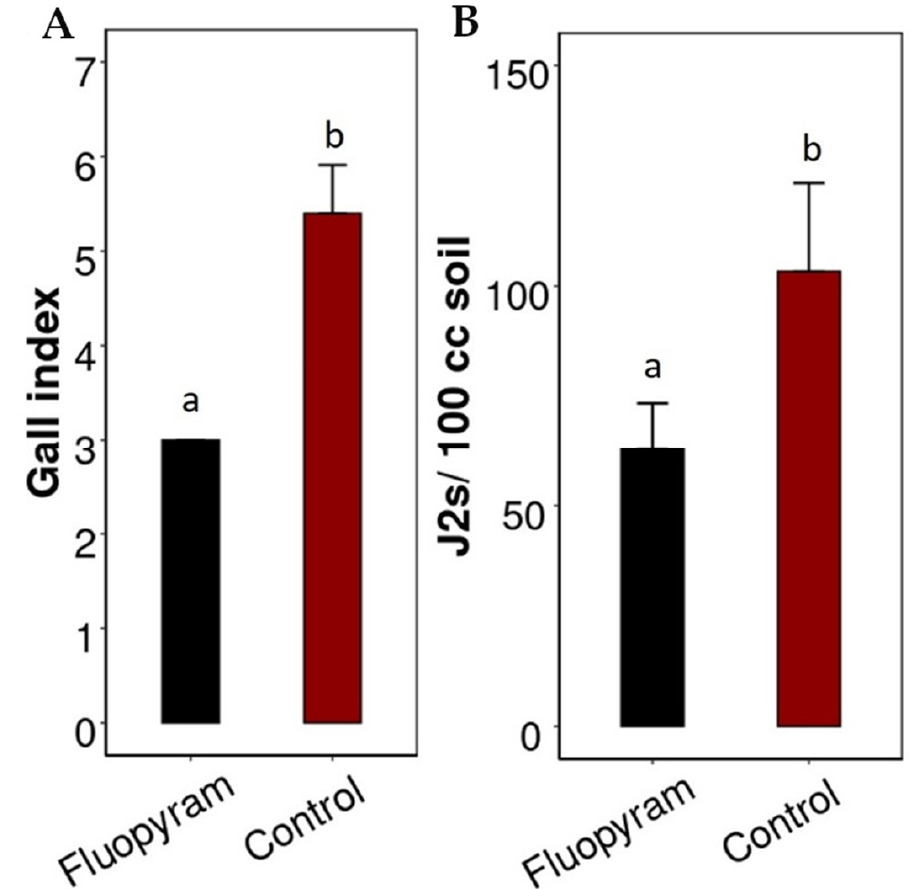
Figure 4. The effect of planting hole treatment with fluopyram on tomato root-gall rating ( A ) and Meloidogyne incognita second-stage juveniles in the soil (soil population) ( B ). Tomato plants were planted in greenhouse soil infected with M. incognita (250 J2s/100 cc of soil). Root galling was indexed according to Zeck’s scale of root-knot infection [19], with 0 = no root galls and 10 = severe galled-up roots (n = 8). Different letters indicate significant differences compared to the control, according to a one-way ANOVA with post-hoc Tukey HSD test ( p ≤